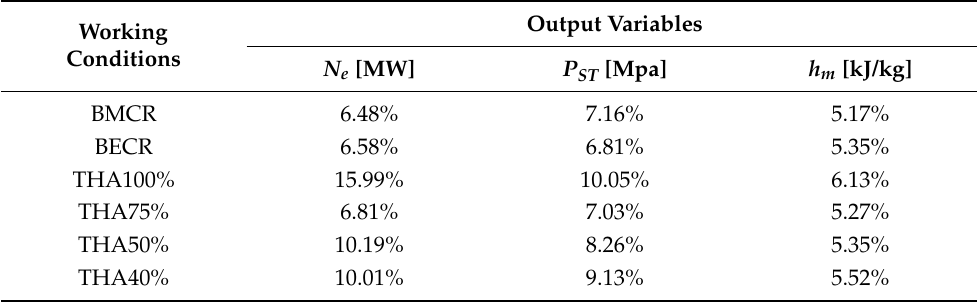
Table 3. The NRMSE of identification sub-models with the inverse M sequence verification signal in the six working